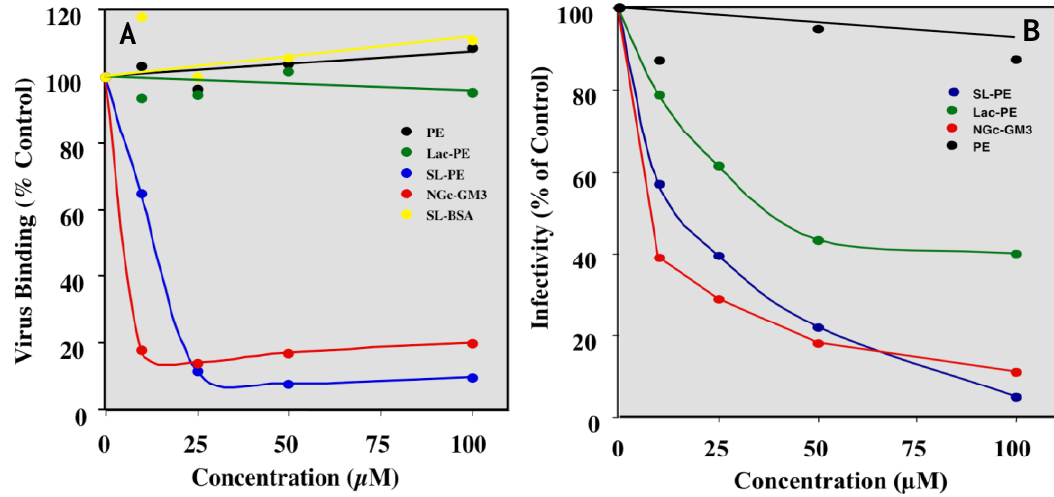
Figure 6. Effect of SLPE and LPE on rotavirus binding and infectivity of MA104 cells. ( A ) Virus (RV TLP) binding and ( B ) infectivity of MA104 cells in the presence and absence of various concentrations of SLPE, LPE, and other lipids or neoglycoconjugates were measured as described in the Experimental Section. (●), PE; (●), LPE; (●), SLPE; (●), NGcGM ; (●), Sialyllactose-BSA (SL-BSA). SL-BSA concentrations are based on µM 3 equivalent of sialic